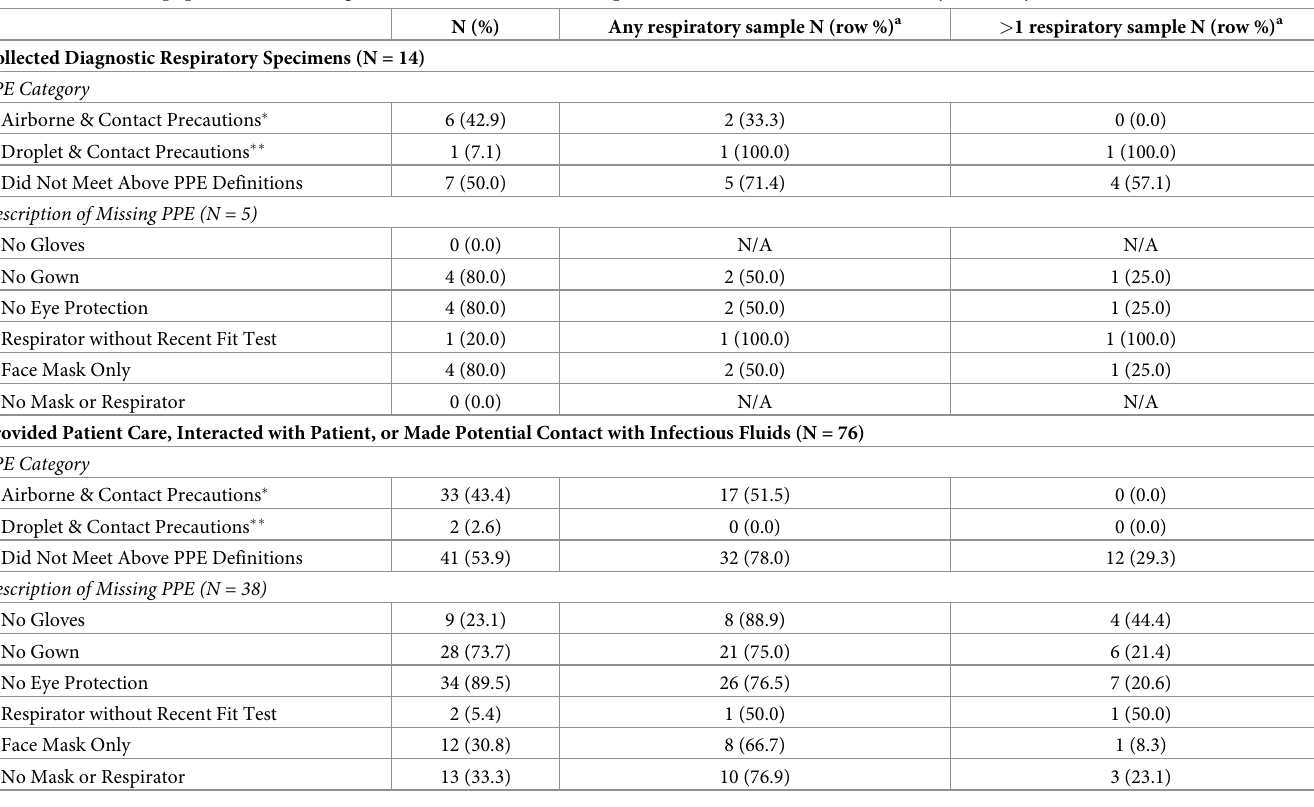
Table 3. Exposures and respiratory sample collection among actively monitored healthcare personnel providing additional information on exposures and use of Personal Protective Equipment (PPE) during interactions with 9 COVID-19 patients (N = 76), United States, January–February